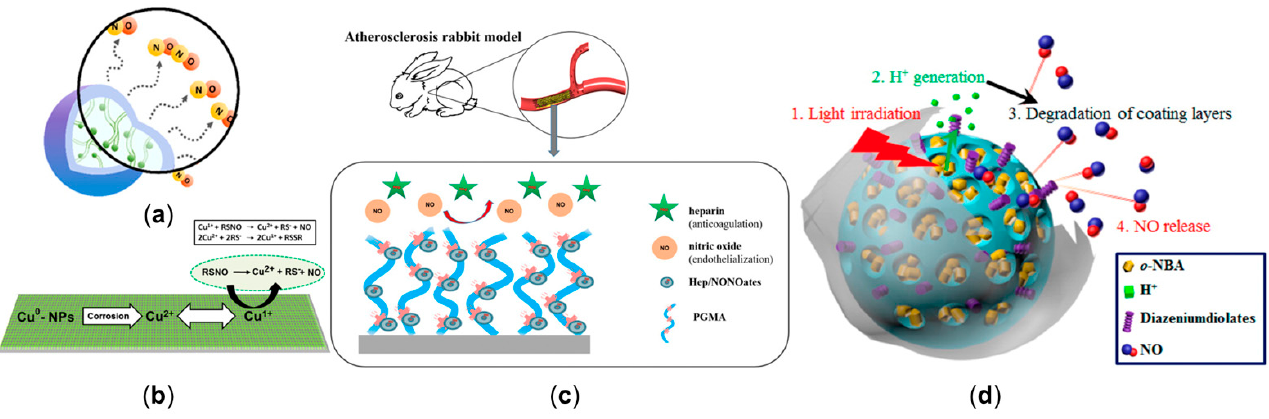
Figure 4. NO release platforms to manipulate cardiovascular nitric oxide delivery. ( a ) Branched polyethylenimine diazeniumdiolate (BPEI/NONOate) was encapsulated into PLGA nanoparticles to release NO in a sustained manner. ( b ) The mechanism of NO release from the combination of catalytic copper nanoparticles and S-nitroso-N-acetylpenicillamine. ( c ) The stent, coated with heparin/NONOate nanoparticles (Hep/NONOates), contributed to the long-term release of NO. ( d ) The light-responsive gatekeeper system for spatiotemporal-controlled NO delivery. Panel ( a ) is adapted with permission from Reference [108] , American Chemical Society. Panel ( b ) is adapted with permission from Reference [104] , American Chemical Society. Panel ( c ) is reproduced with permission from Reference [109] , American Chemical Society. Panel ( d ) is reproduced with permission from Reference [110] , American Chemical Society.